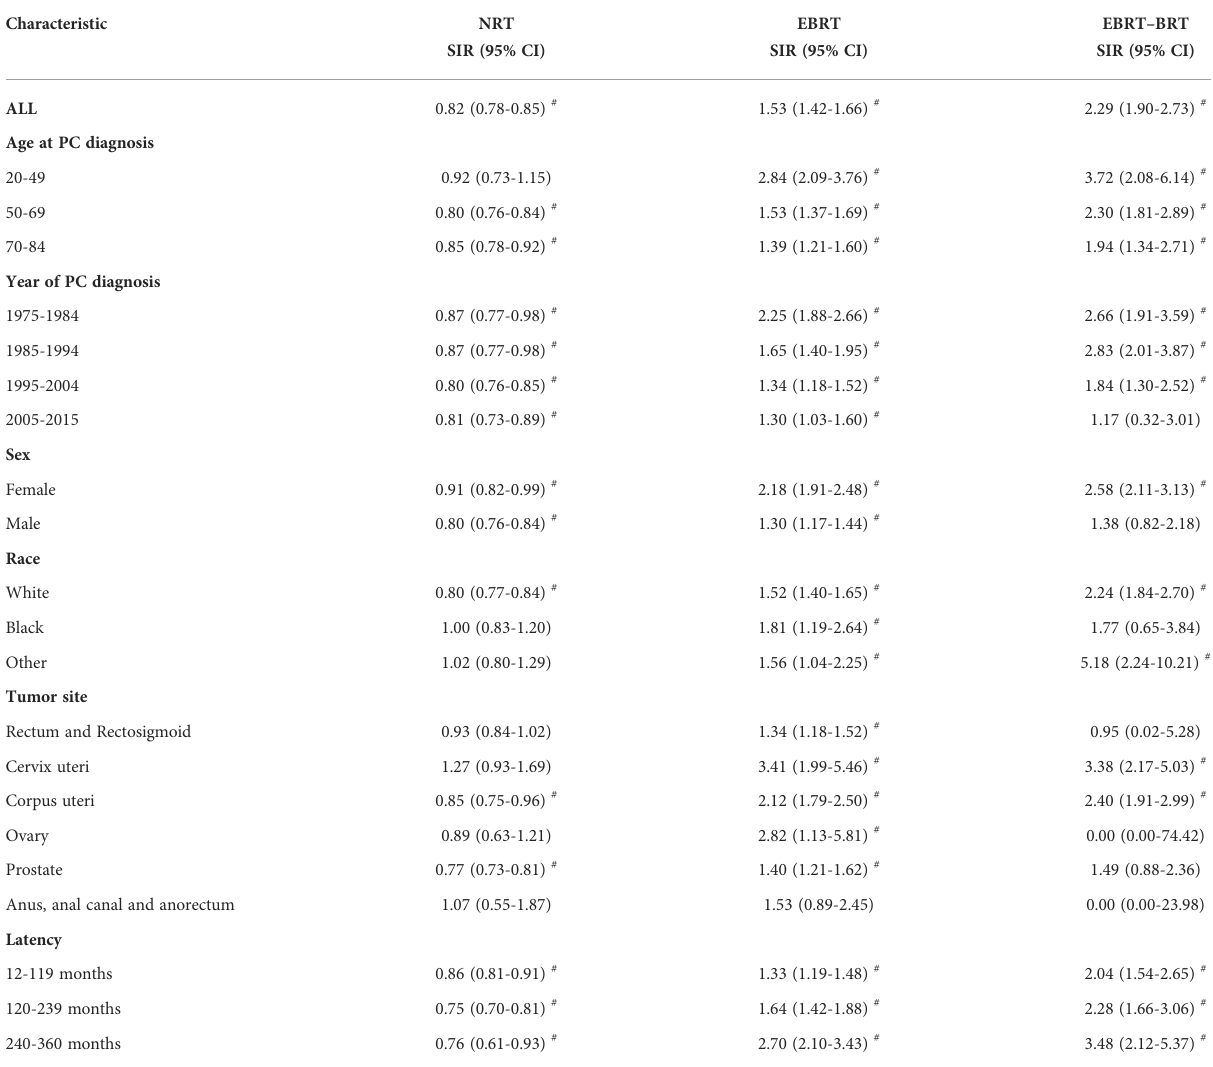
TABLE 3 Standardized incidence ratio (SIR) of SBC.